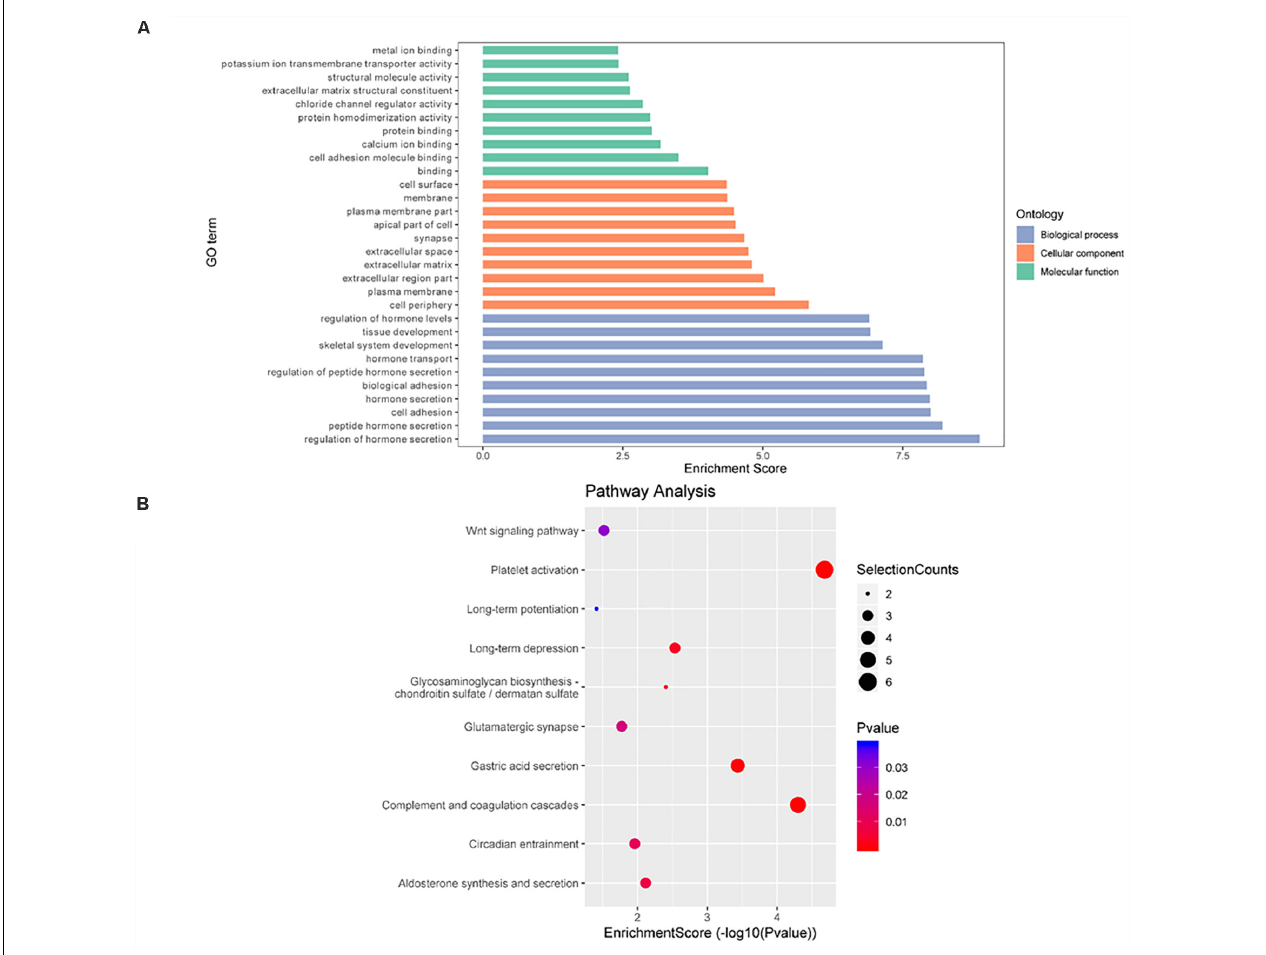
FIGURE 6 | Gene ontology and Kyoto Encyclopedia of Genes and Genomes analyses of coding genes containing DMMSs. (A) Major gene ontology terms were enriched for the genes containing m6A sites with reverse methylation trend between IvC and TvI. (B) Major enriched pathways for the genes containing m6A sites with reverse trend between IvC and